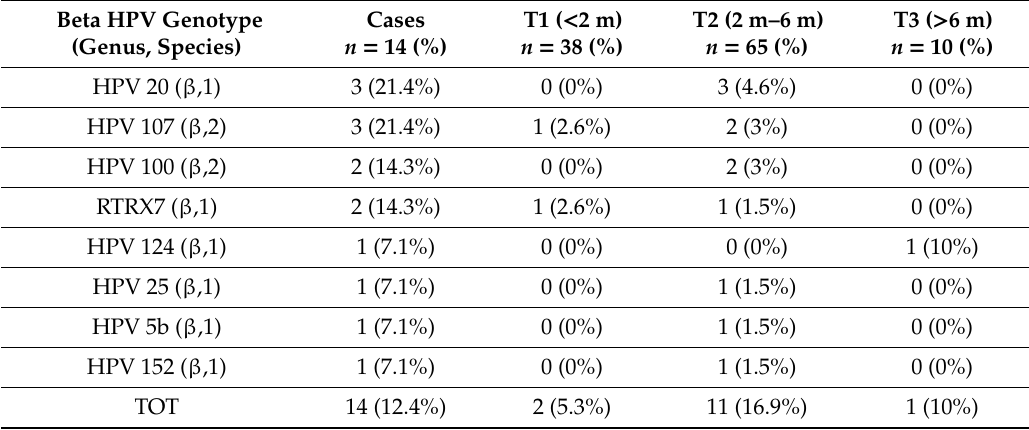
Table 2. List of HPV types detected in the study, genus and species, and relative percentage among